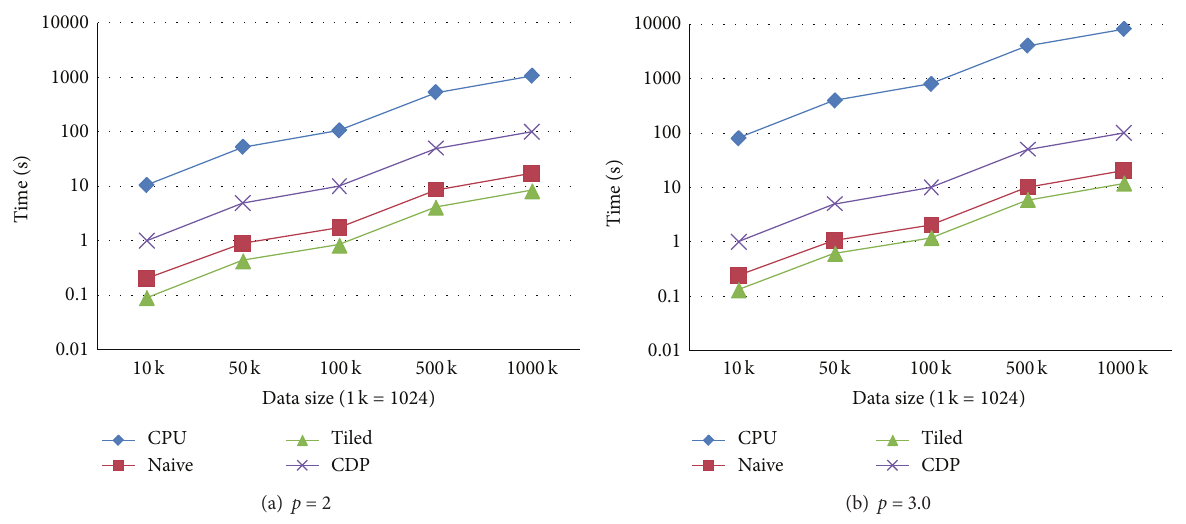
Figure 4: Execution times in the test case when the number of data points is fixed and the number of prediction points differs. (a) The form in which the power parameter is set to 2. (b) The form in which the power parameter is set to